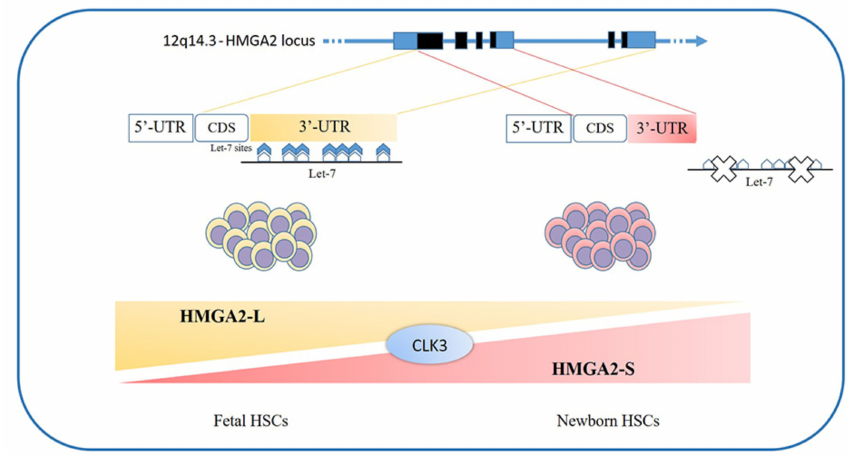
Figure 1. HMGA2 development-specific isoforms: HSCs feature distinct alternative splicing patterns in various key hematopoietic regulators, one of which is HMGA2. In humans, two alternative splicing isoforms have recently been discovered: the HMGA2-L isoform, which is sensitive to degradation by let-7 and is dominant in fetal HSCs, and the HMGA2-S isoform, that is resistant to degradation by let-7 and is prevalent in newborn HSCs. The two isoforms reveal alternative 3’UTR usage; they share the first three exons and di ff er in their terminal exon usage (including C-terminal domains and 3’UTRs). The HMGA2-S 3’UTR is one third the length of the HMGA2-L 3’UTR and lacks the seven let-7 sites as well as the other most conserved miRNA sites. The balance between alternative isoforms and the escape from miRNA-mediated control seems to depend on the activity of the splicing kinase CLK3, which promotes exon skipping and thus influences the HMGA2 splicing pattern [8]. HSCs-hematopoietic stem cells; 3’UTR-3 (cid:48) -Untranslated